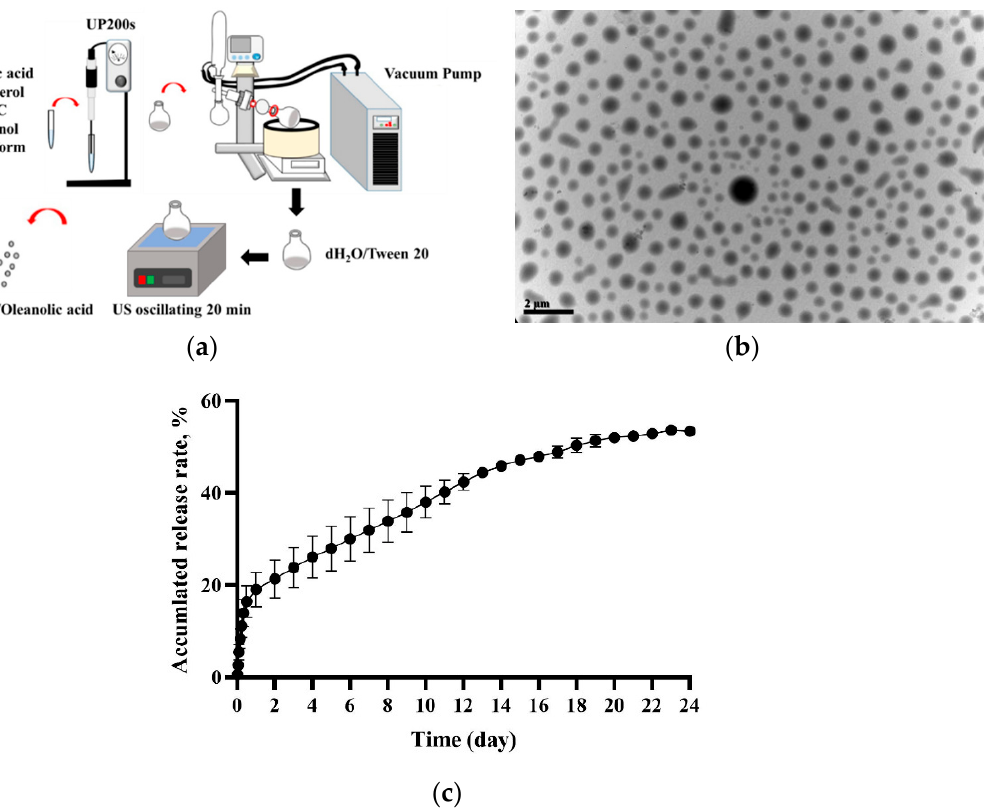
Figure 1. ( a ) Schematic of liposomal OA nanoparticle (Lipo ‐ OAs) preparation; ( b ) Transmission election microscopy images of Lipo ‐ OAs; ( c ) OA release profile of Lipo ‐ OAs.